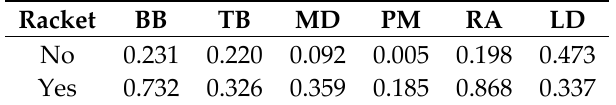
Table 2. P -value of mean amplitude for 20 s Dash (forward